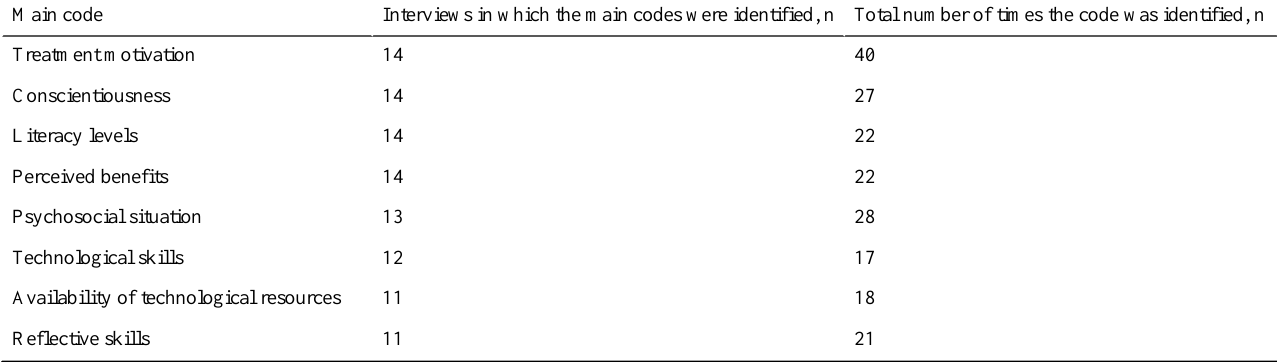
Table 3. Main codes and the number of interviews in which they were identified (Nint=18) and the total number of times that a code was identified